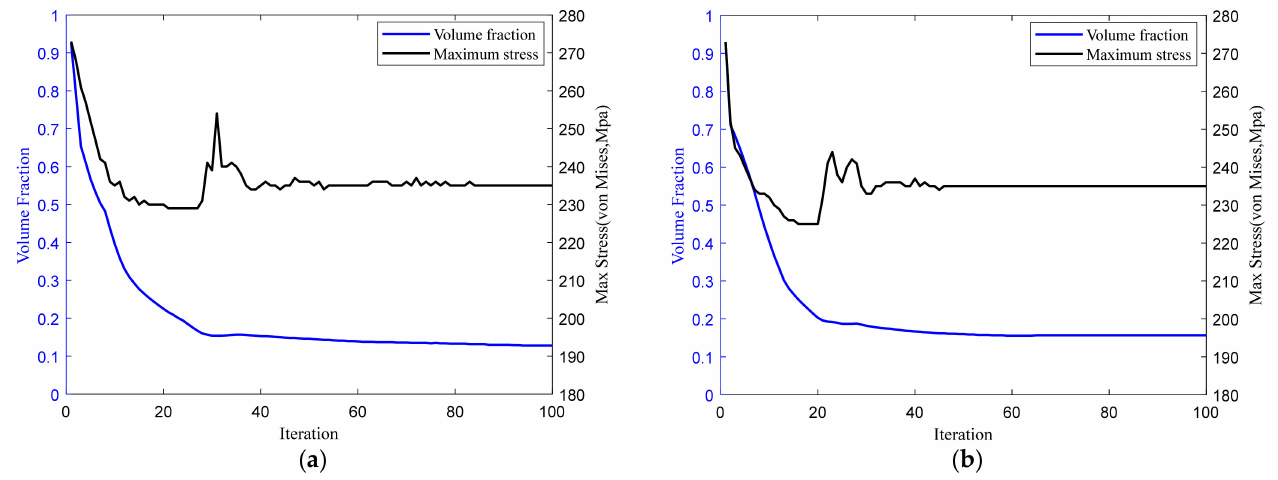
Figure 21. Volume fraction and maximum von Mises stress iteration curves of ( a ) DTO and ( b )